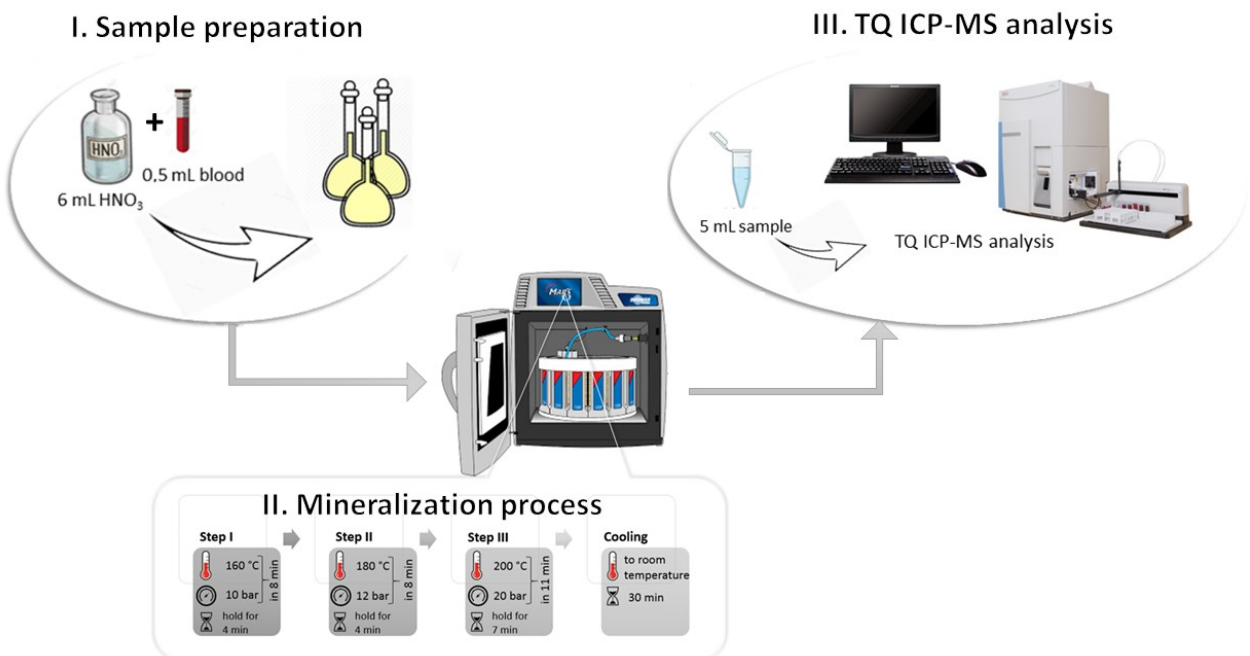
Figure 4. Sample preparation methodology divided into three main sections with included detail on the stage of the mineralization process—temperature and pressure. I. Sample preparation: add 6 mL concentrated HNO3 to 0.5 mL of blood and transfer in a special microwave vessel applied for mineralization—wait 30 min. II. Mineralization process: the three-step microwave program. III. TQ ICP-MS analysis: preparation of 5 mL of mineralizate for analysis.